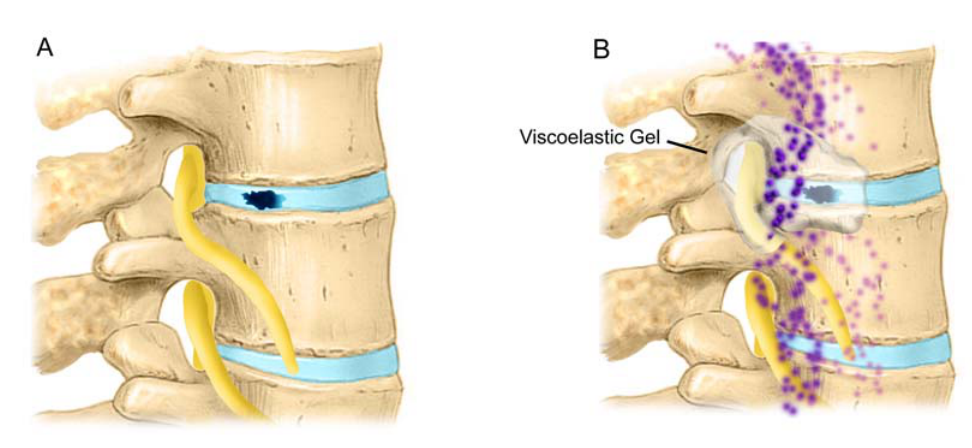
Figure 8. A ) Disc tear/rupture/annulotomy exposes epidural tissues to the nucleus pulposus. The nucleus pulposus elicits an immune response in the epidural space [121]. B ) Herniated lumbar disc tissue from symptomatic patients contains elevated levels of TNF- α , nitric oxide (NO), prostaglandin E2 (PGE2); IL-1 β , IL-6, IL-8, COX-2, and